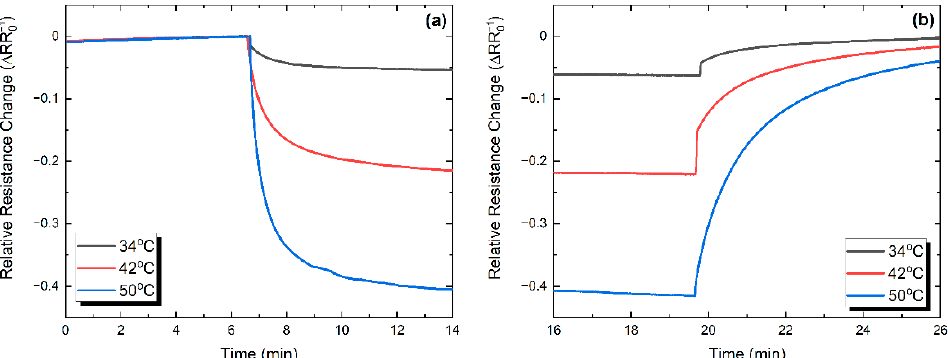
Figure 14. Normalized response ( a ) and recovery ( b ) behavior for three thermal pulses for the f ‐ rGO sample.